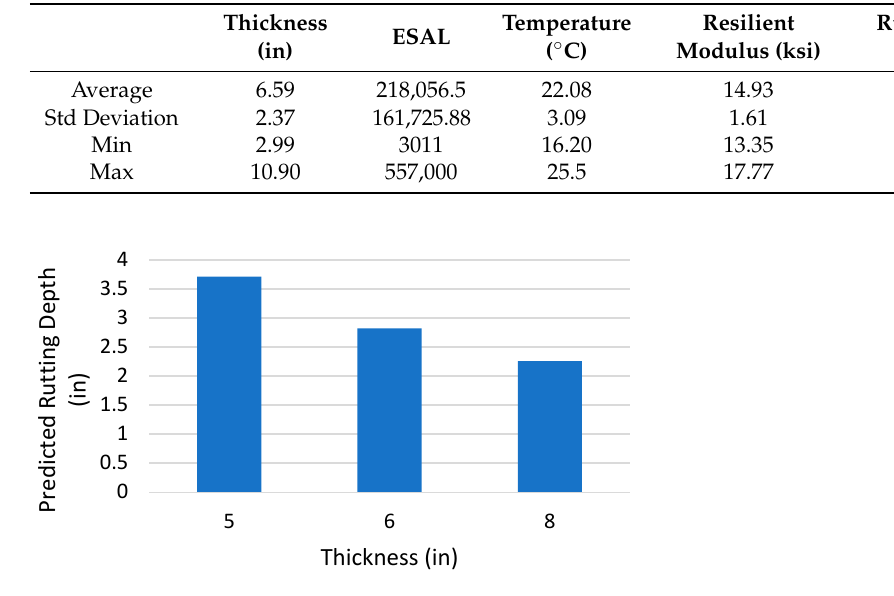
Figure 8. Model sensitivity for Thickness. Figure 8 . Model sensitivity for Thickness.